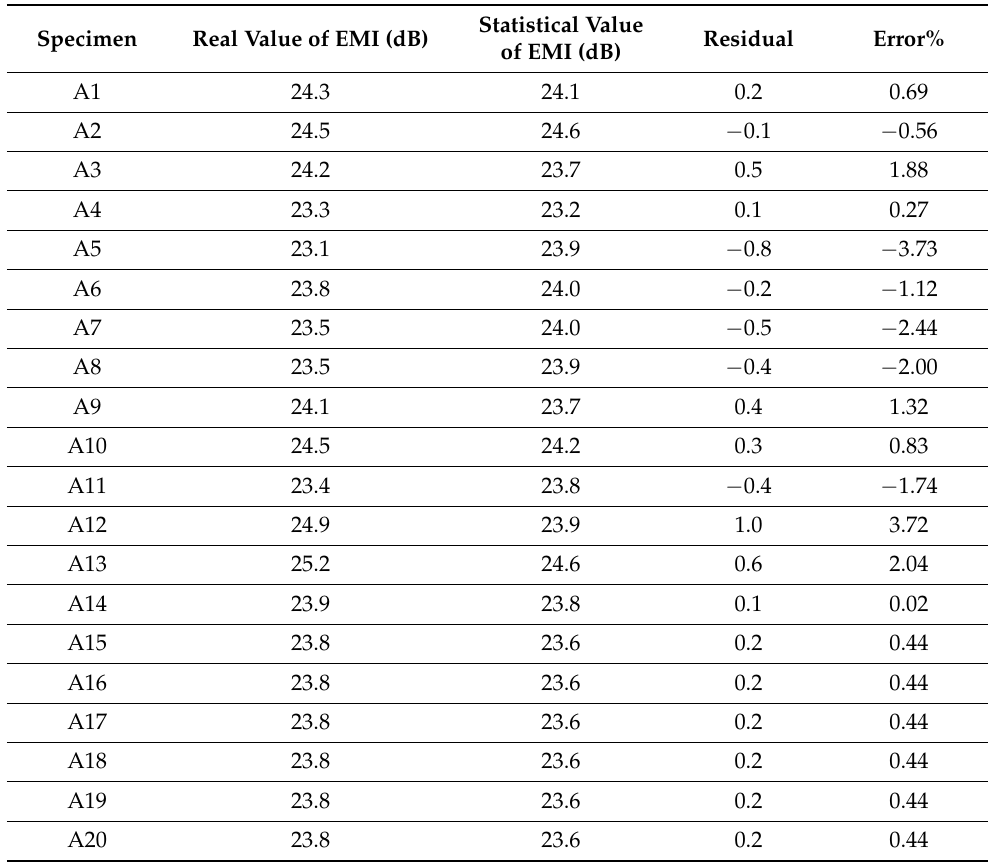
Table 8. EMI error estimation between real and statistically anticipated values. Specimen